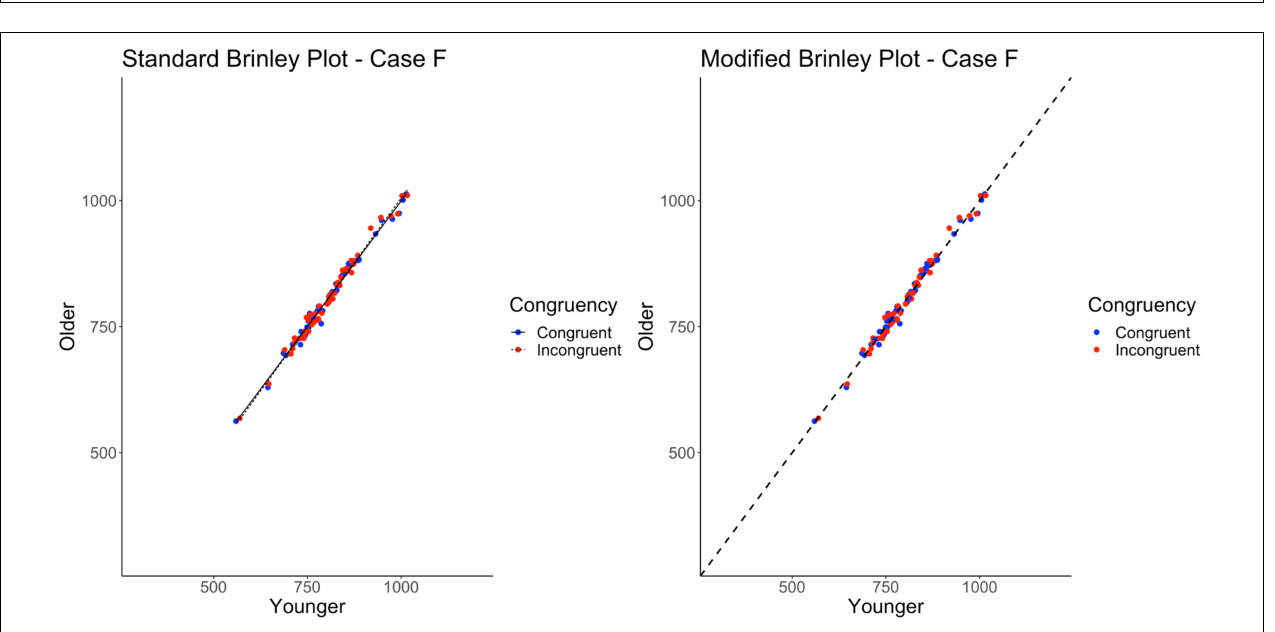
FIGURE 8 | Standard and modified Brinley plots—Case F data. Standard and modified Brinley plots (left and right, respectively) for the Case F simulated data which was simulated such that all effects were null. Means (SD) used for Case F were as follows: Young Congruent = 800 (150), Young Incongruent = 800 (150), Old Congruent = 800 (150), Old Incongruent = 800